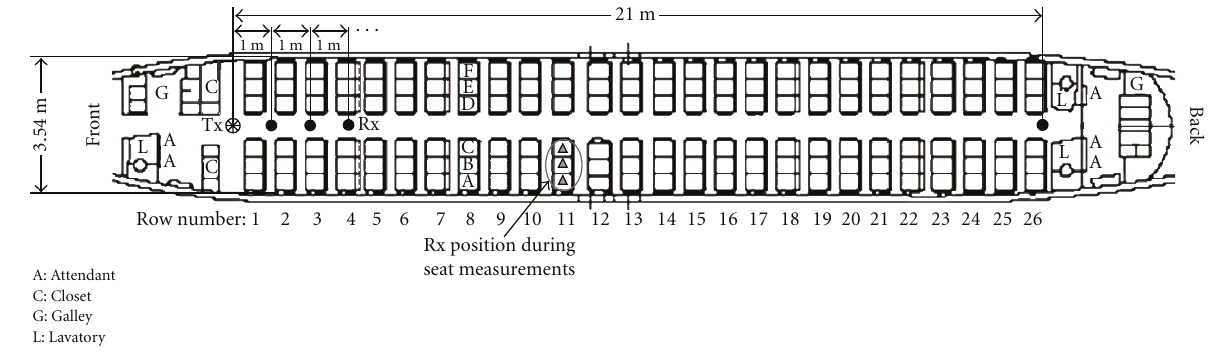
Figure 2: Ground plan of the measurement environment.